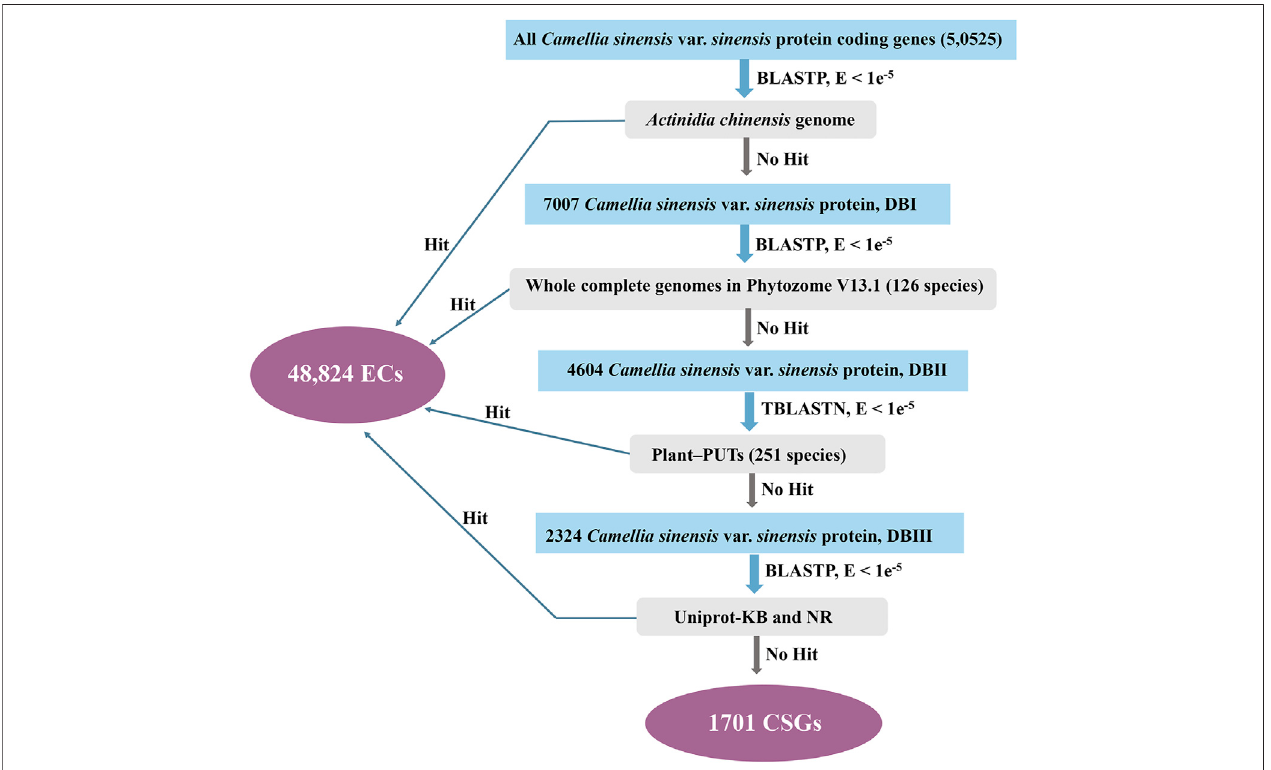
FIGURE 1 | Procedure for identifying lineage-speci fi c genes in Camellia sinensis var. sinensis